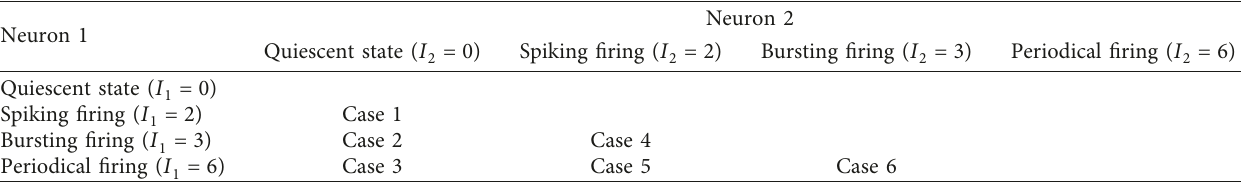
Figure 6: ISI bifurcation diagrams of the coupled model with external stimulation current I . For (a) chaotic state through period-doubling bifurcation with d � 1 . 444444 I + 0 . 366667, D � 3, and τ � 0 . 01; (b) period-adding bifurcation with d � 2 I − 2, D � 3, and τ � 0 . 1. The initial values are selected with (0.1, 0.01, 1.05, 0.1, 0.01, 1.05). Table 1: Two HR neurons with different firing patterns are coupled under six kinds of